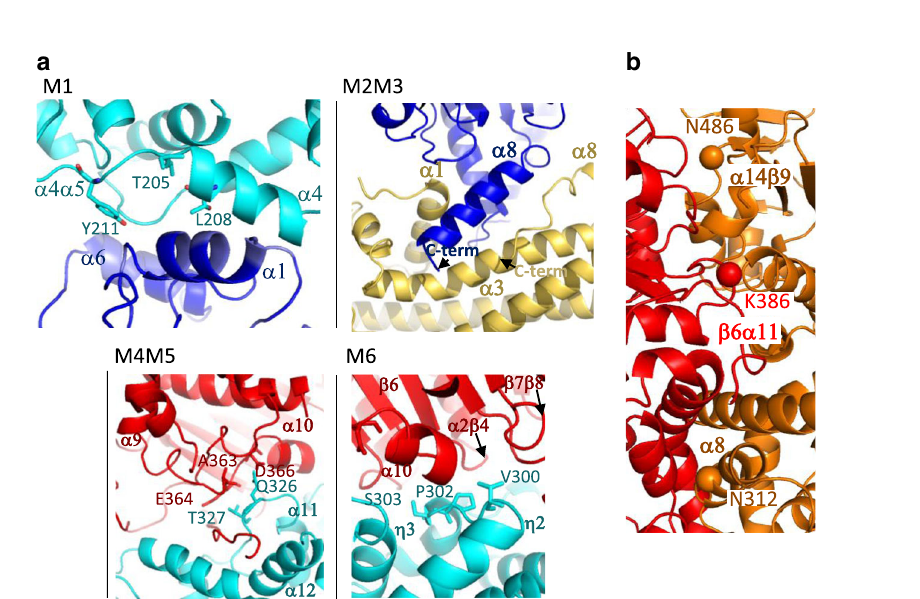
Fig. 4 Validation of the hetero-pentameric T4CC complex and of the interface between DotL subunits in the proposed T4CC hexameric assembly. a Location and structure of the regions M1 to M6 targeted for mutations. Mutated residues in each of the mutants are labelled as well as the secondary structures in which they are involved. Description of the 6 regions and mutants are provided in main text. b The interface between two adjacent DotL subunits in the proposed T4CC hexamer (shown in red and orange ribbons). Three mutations reported by Sutherland et al. 11 to affect intracellular growth locate to this interface. The C α atom of these residues is shown as a sphere. The residues as well as the secondary structures they belong to are labelled. Table 1 Probing the observed protein-protein interaction network by site-directed mutagenesis.